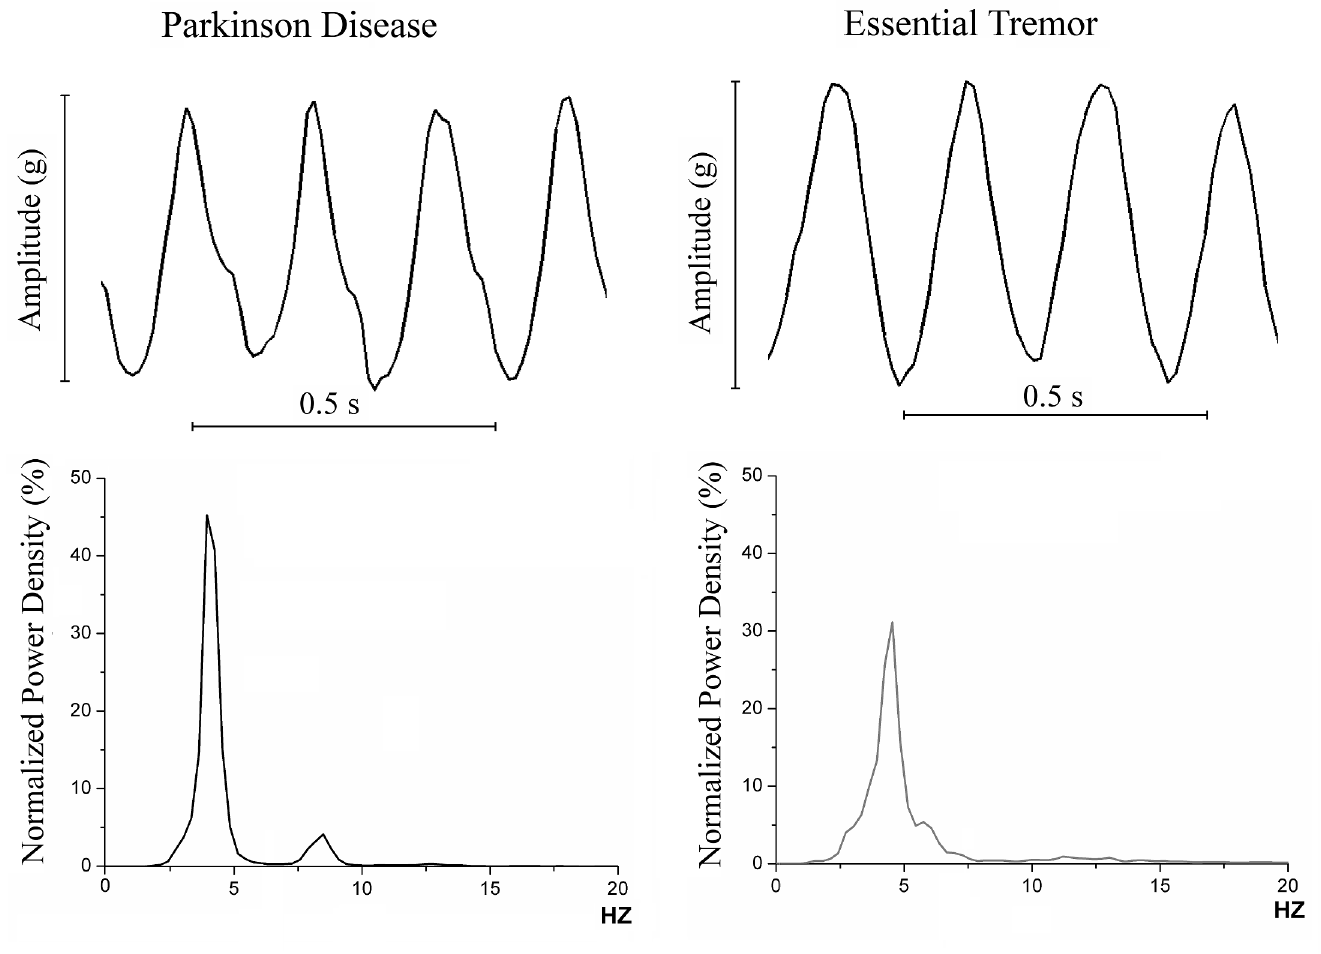
Fig 2. Upper section, examples of the smartphone’s accelerometer signal morphology in Parkinson’s Disease(PD) and essential tremor (ET). Lower section, examplesof normalized power spectral density of tremor in PD and ET subjects.